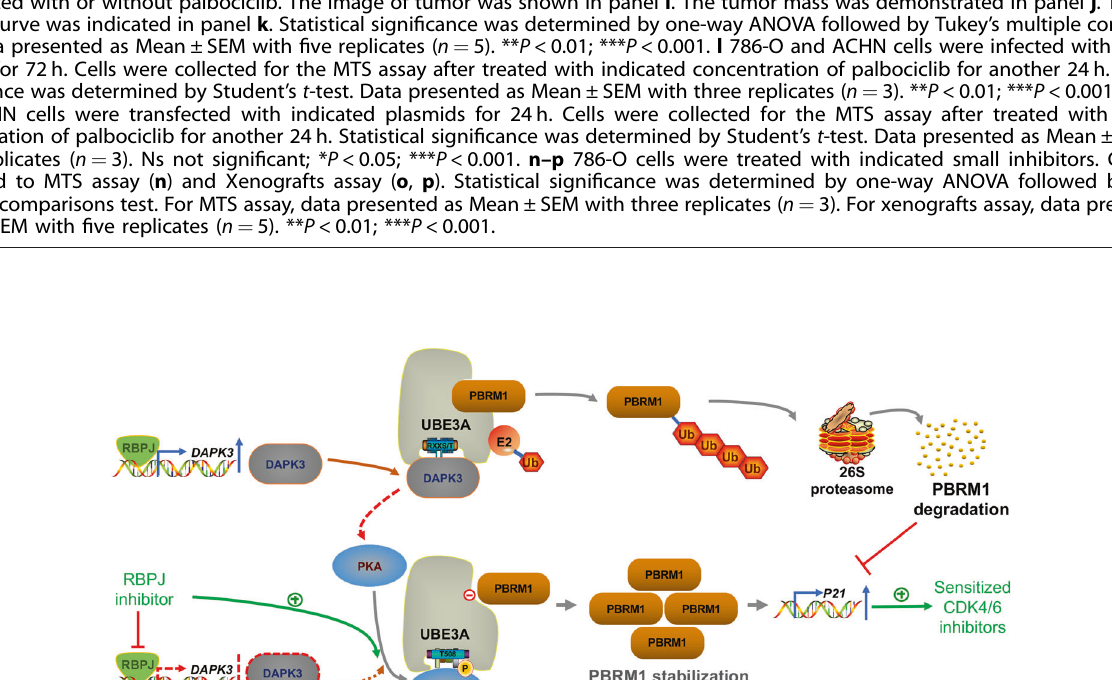
Fig. 7 A hypothesis model depicted that PKA phosphorylated UBE3A to prevent UBE3A degrading PBRM1. DAPK3 competed with PKA to bind with UBE3A and enhance the PBRM1 degradation in renal cancer cells. PBPJ transcriptionally regulated DAPK3 expression and then promoted UBE3A-mediated degradation of PBRM1. Then, PBRM1 increased the p21 expression and sensitized renal cancer cells to CDK4/6 inhibitors. In combination with RBPJ inhibitors, CDK4/6 inhibitors synergistically enhanced renal cancer tumor suppressor protein PBRM1 was a bona fi de substrate of UBE3A for degradation. Although only the mass spectrometry data of PBRM1 indicated that PBRM1 interacted with UBE3A, there was no PBRM1 in the mass spectrum data of UBE3A. The reason might be that the mass spectrometry data are very random, and not all proteins that can bind to UBE3A will appear in the mass spectrometry data of UBE3A at one time. We have con fi rmed the interaction of UBE3A and PBRM1 in the following co-IP and GST pull-down assay. However, the cancer-related role of UBE3A in RCC remains unclear, and more investigation should be performed in the future.